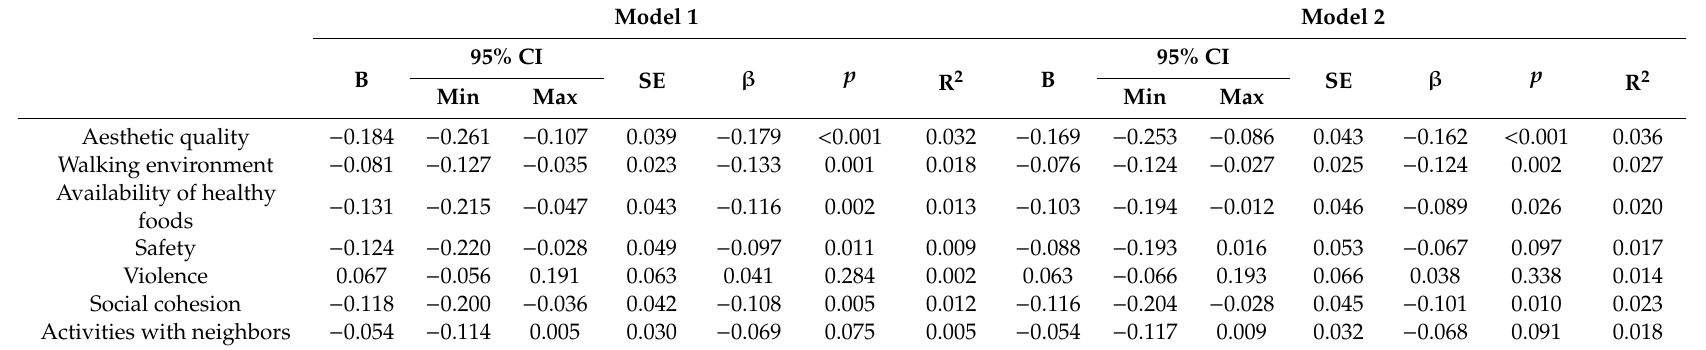
Table 4. Association between neighborhood characteristics and internalizing